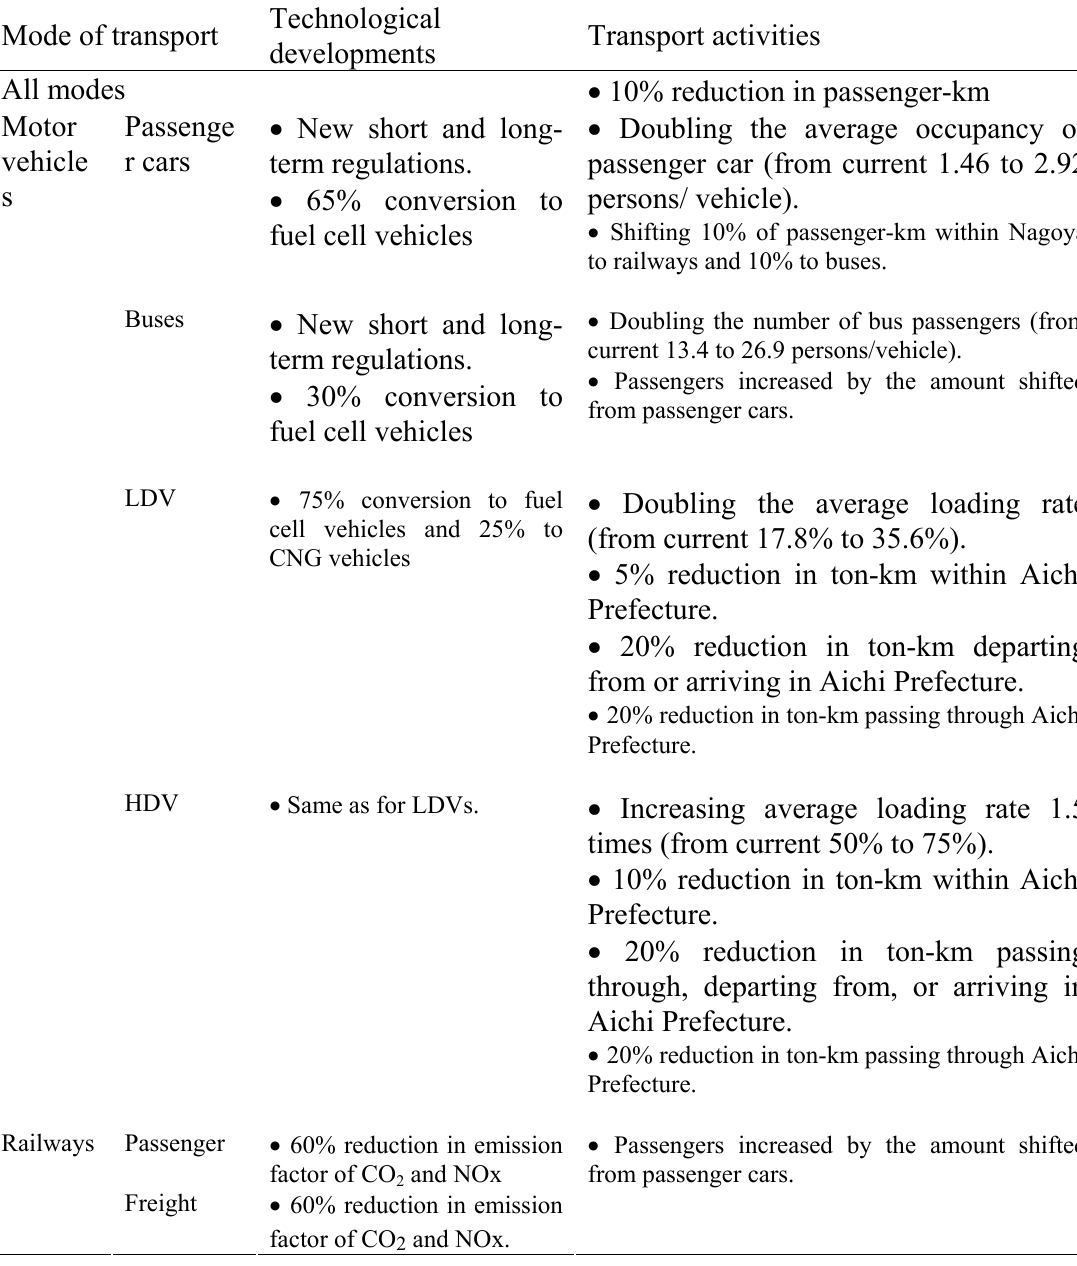
Table 16. Assumptions on technological developments and transport activities in EST3 Scenario (Aichi